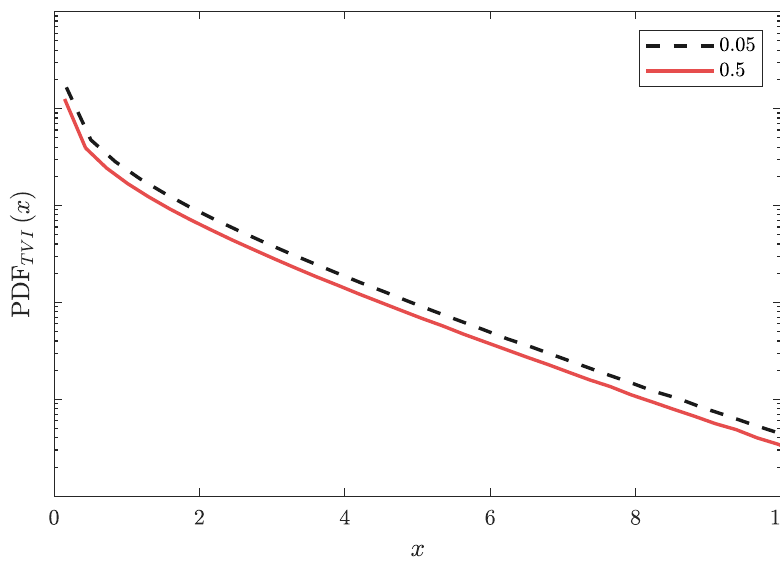
Figure 5. Probability density function of T VI (54) as a function of the residual ˆ e MS ,1 under H 0 , approximated by MCM. Vertical axis is in logarithmic scale. The strong peaks at 0 for ˆ τ 1 ≤ 1 are not displayed. The dashed black and the solid red curve relates to σ W / σ 1 = 0.05 and σ W / σ 1 = 0.5,